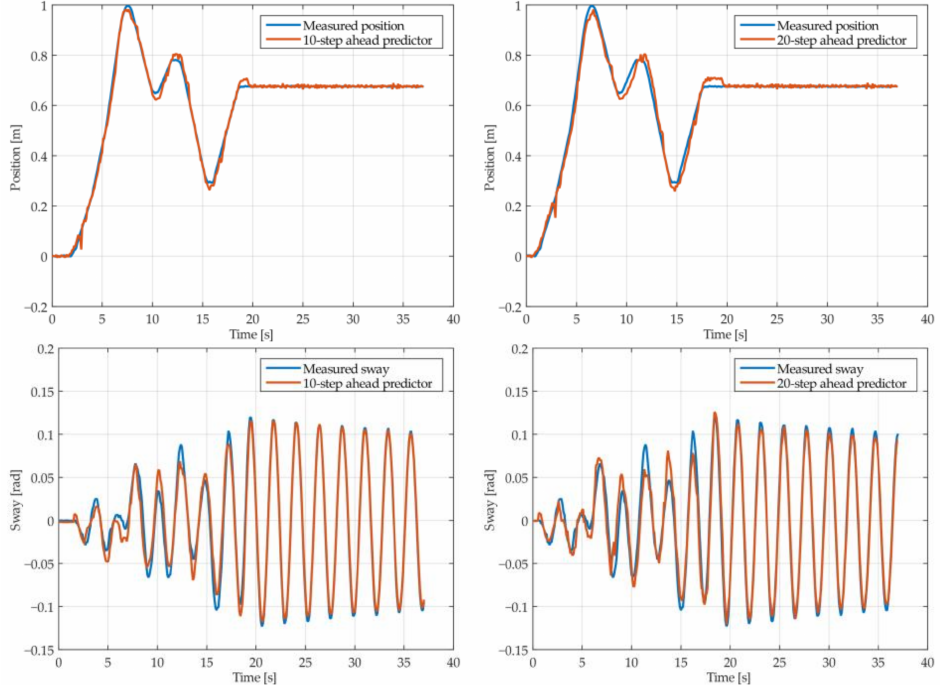
Figure 13. The 10- and 20-step ahead prediction with the MGGP model of the experimental crane position and payload sway with 0.9-meter rope and 10 kg payload